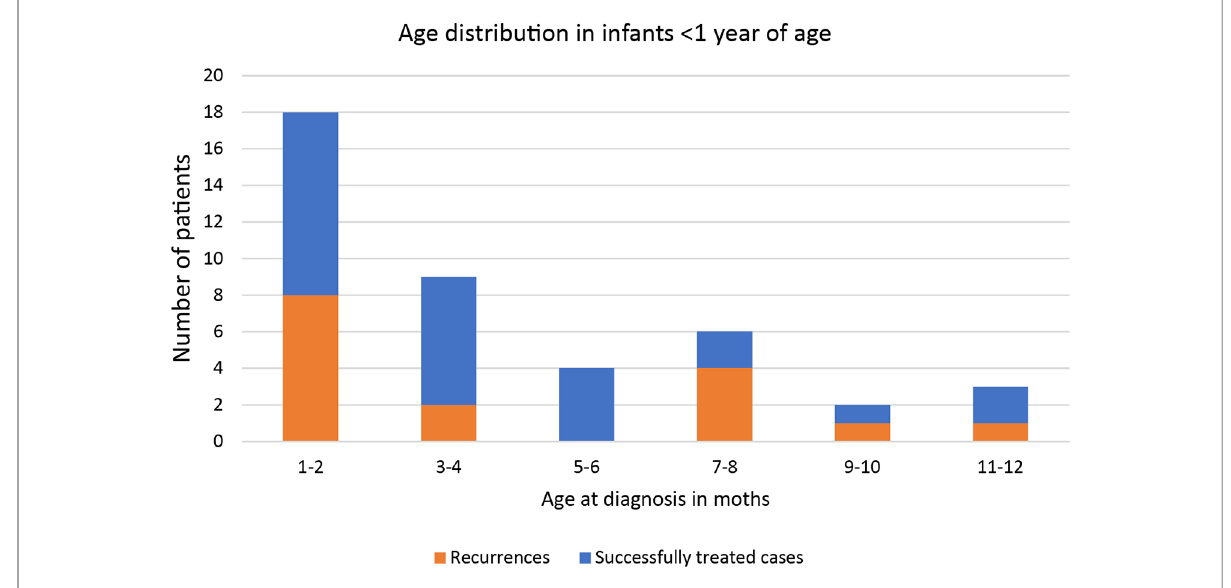
FIGURE 2 Distribution of incidence and outcome by month of onset of perianal abscess for infants under 1 year of